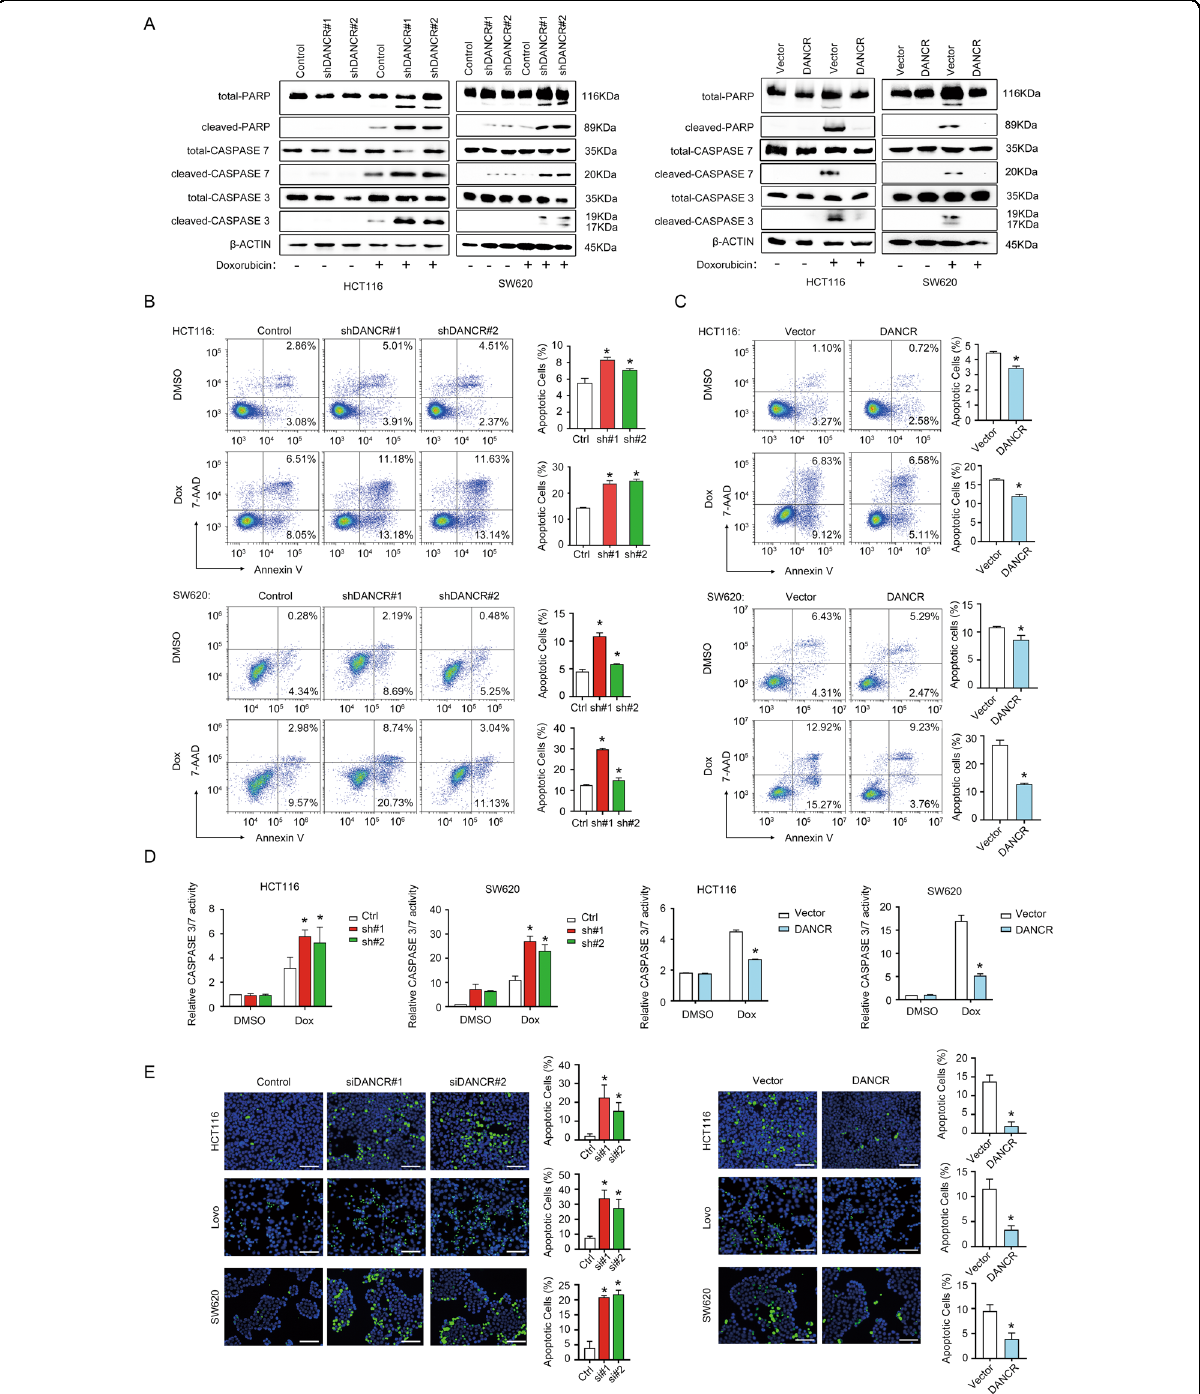
Fig. 2 DANCR regulated apoptosis of colorectal cancer cells in vitro. A Left: Western blotting showed increased expression of total and cleaved PARP, CASPASE 7, and CASPASE 3 upon treatment with 200 nM Doxorubicin for 24 h in HCT116 and SW620 cells with shDANCR. Right: DANCR overexpression in HCT116 and SW620 cells repressed the expression of cleaved PARP, cleaved CASPASE 7, and cleaved CASPASE 3 detected by Western blotting. B Representative images of Annexin V fl ow cytometry assays and data statistics showed increased apoptotic cell numbers upon DANCR silencing in HCT116 and SW620 cells, which was treated with DMSO or 200 nM Doxorubicin for 24 h. * p < 0.05. C Annexin V fl ow cytometry assays showed DANCR overexpression increased tolerance to apoptosis in HCT116 and SW620 cells treated with DMSO or 200 nM Doxorubicin for 24 h. * p < 0.05. D The effects of DANCR depletion and DANCR overexpression on the CASPASE 3/7 activity in HCT116 and SW620 cells in the presence or absence of 200 nM Doxorubicin for 24 h. * p < 0.05. E TUNEL staining and statistical analysis in HCT116, LoVo, and SW620 cells with DANCR siRNAs (left) or with DANCR overexpressing vectors (right). Bar, 100 μ m. * p <